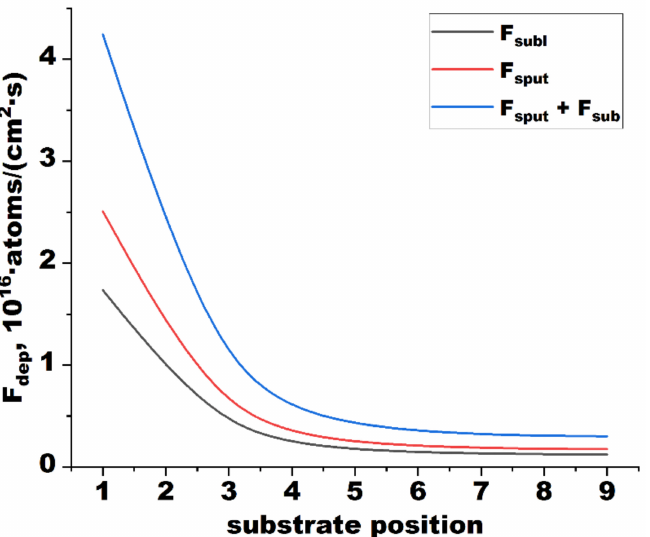
Figure 3. Total particle flux density ( F dep ) to a substrate due to target sputtering ( F sput ) and sublimation ( F subl ) depending on substrate